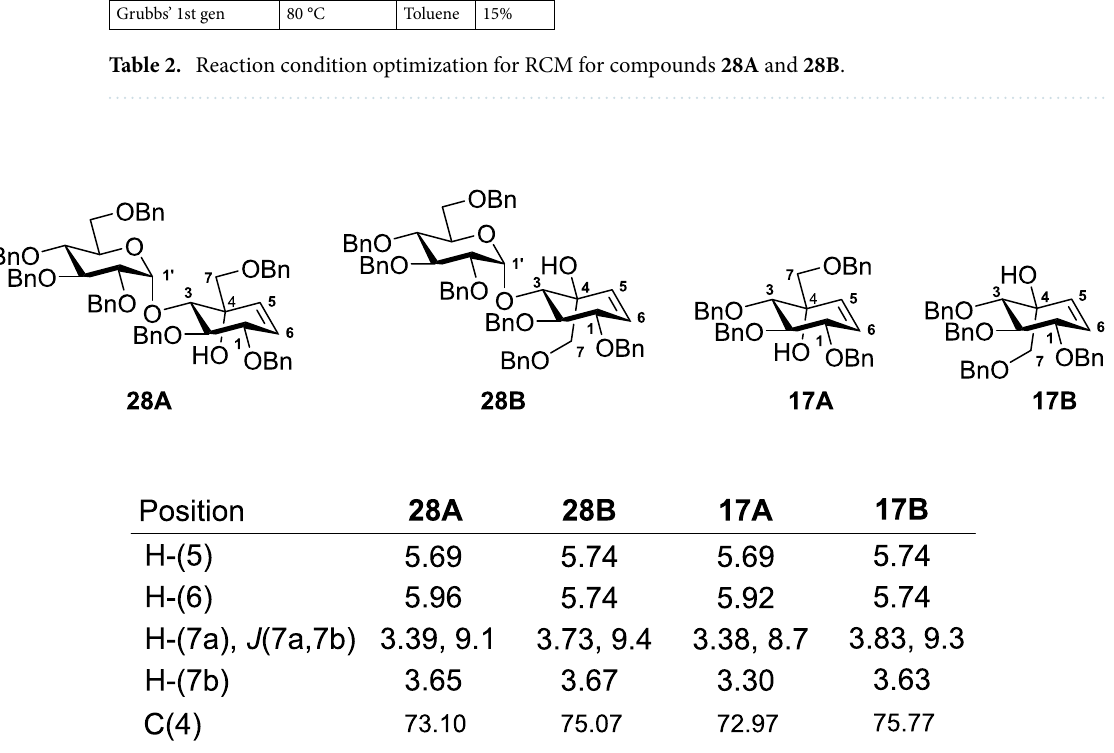
Table 3. Comparing the NMR shift values of compound 28A , 28B , 17A and 17B